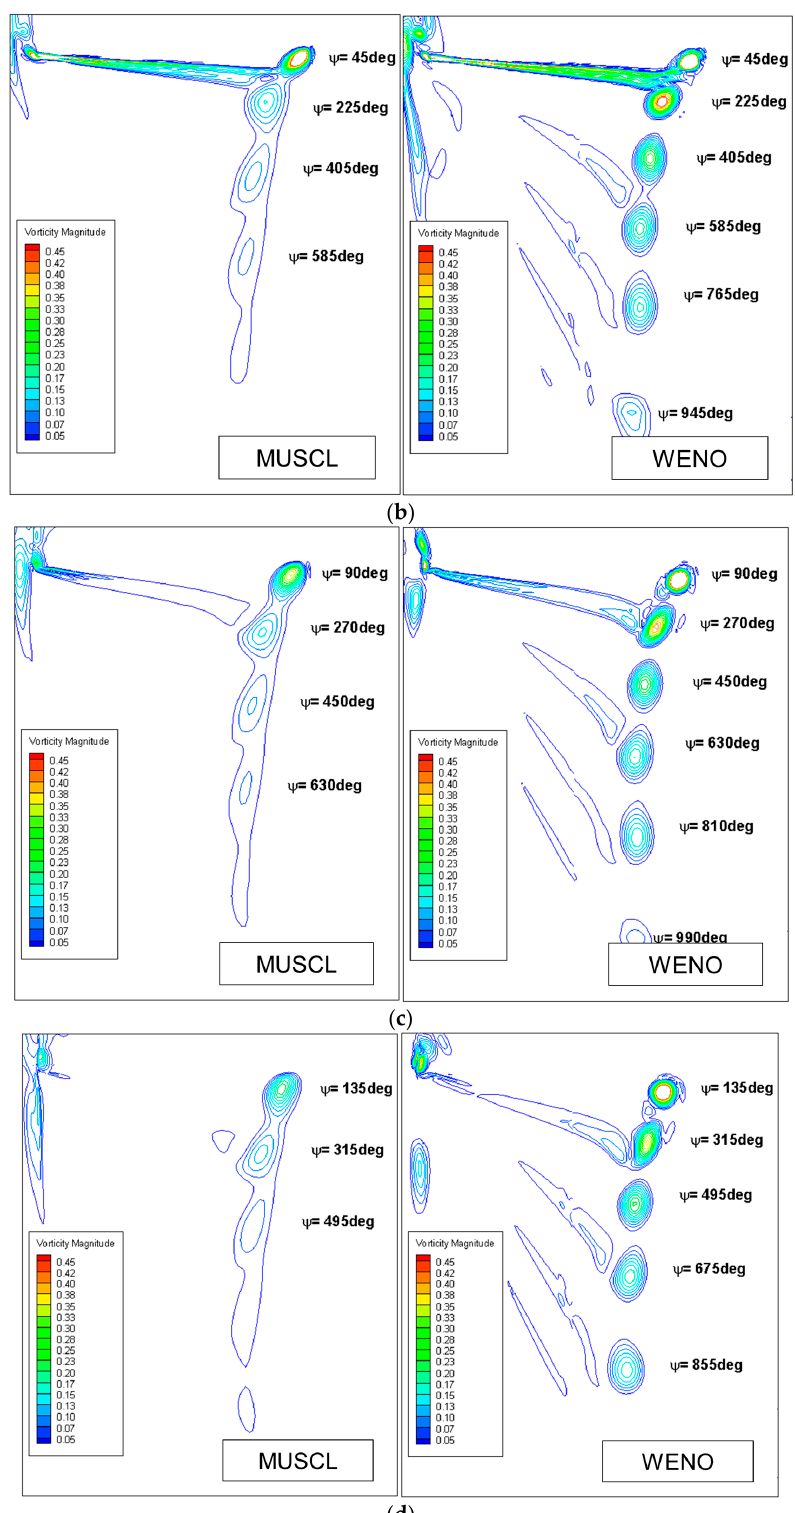
Figure 9. Comparison of vorticity distributions on four radial sections. ( a ) ψ = 0 deg, ( b ) ψ = 45 deg, ( c ) ψ = 90 deg, ( d ) ψ = 135